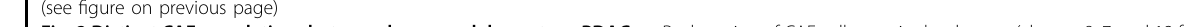
Fig. 2 Distinct CAF populations between loose- and dense-type PDACs. a Reclustering of CAF cell types in the data set (clusters 8, 7, and 12 from Fig. 1c), represented as a UMAP plot. b Violin plot showing normalized expression of marker genes for different CAF subclusters. c Hallmark pathways enriched in the four CAF subclusters (subclusters 0, 3, 4, and 5). The size of the dot represents the intersection of marker genes of the subcluster with hallmark pathway gene sets (KEGG and GO), and the intensity of the color indicates log 10 ( P value). d Nine PDAC samples undergoing scRNA-seq received multiplex immuno fl uorescence staining to con fi rm the CAF subgroups in PDACs. Multiplex staining for relevant subCAF markers (APOD for C0 iCAF, orange; POSTN for C3 myCAF, red; PLA2G2A for C4 meCAF, green) showed three distinct populations (the representative image was from one loose-type PDAC). e Proportion of six different CAF subclusters in dense- and loose-type PDACs (four dense cases, three loose cases). The ratio of meCAF (C4) to myCAF (C3) for four dense cases was compared with three loose cases. The y axis represents the ratio of meCAF/myCAF for n = 7 cases (four dense cases and three loose cases). Data are presented as means ± SEM. The result showed that myCAF is the major CAF subgroup in dense-type PDAC while meCAF is the major CAF subgroup in loose-type PDAC. f Multiplex immuno fl uorescence staining was conducted in nine PDAC samples undergoing scRNA-seq to con fi rm the changes in the CAF subgroups in dense- and loose-type PDACs (POSTN for C3 myCAF, red; PLA2G2A for C4 meCAF, green). Representative images (one dense-type PDAC and one loose-type PDAC from nine PDAC samples) were shown (images of all nine patients were shown in Supplementary Fig. S6), and the results showed that the expression of myCAF marker in dense-type PDAC was high while meCAF marker was highly expressed in loose-type PDAC. g The ratio of meCAF (PLA2G2A + CAFs) to myCAF (POSTN + CAFs) for seven cases (four dense-type and three loose-type cases). The y axis represents the ratio of meCAF/myCAF in visual fi elds (40×). Data are presented as means ± SEM. All statistical analyses were performed with the two-sided Mann – Whitney U test. * P <